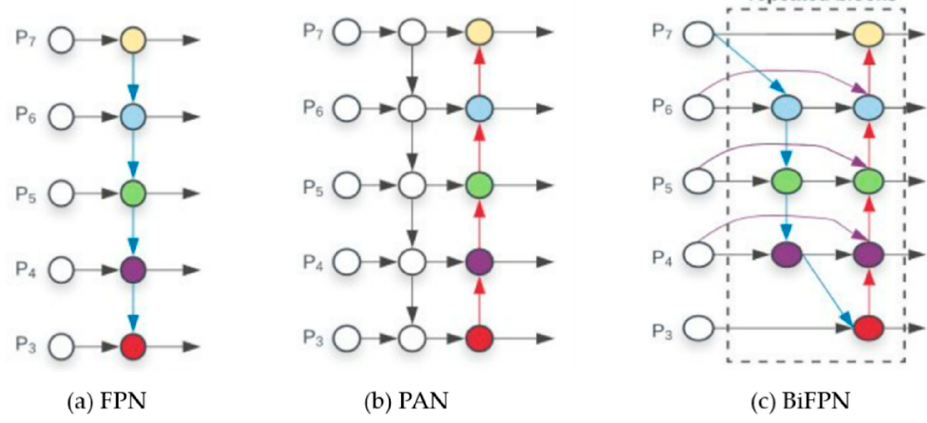
Figure 4. FPN, PAN, and BiFPN structures.